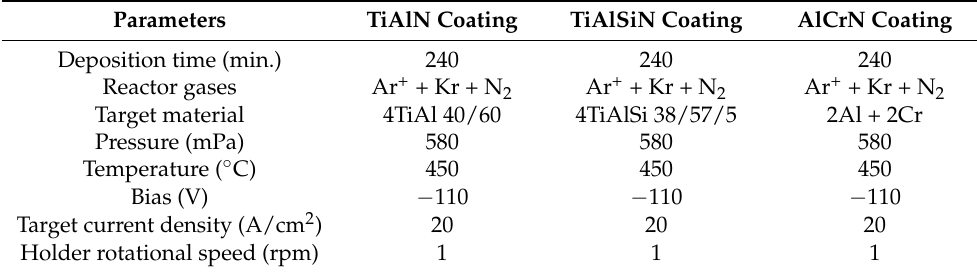
Table 2. TiAlN, TiAlSiN and AlCrN PVD coatings’ deposition parameters. Parameters TiAlN Coating TiAlSiN Coating Deposition time (min.)